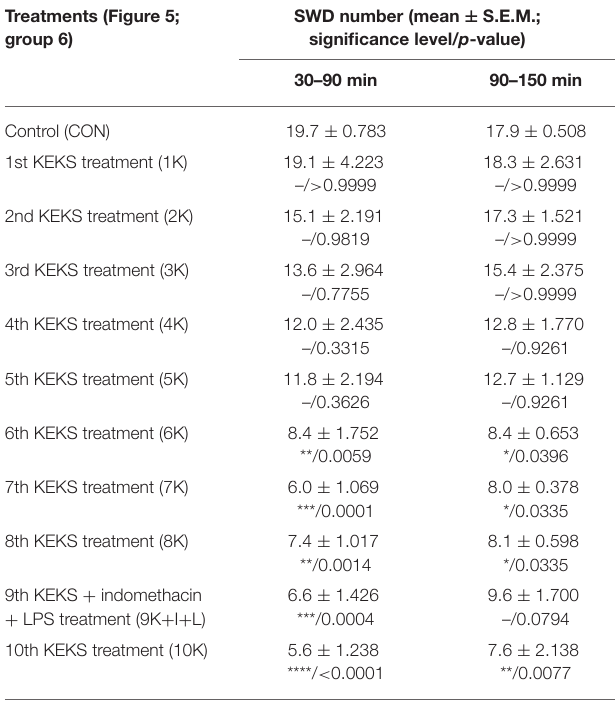
TABLE 7 | Effect of KEKS food on IP indomethacin plus lipopolysaccharide-evoked changes in SWD number on the 9th KEKS day (9K + I + L; Figure 5 , group